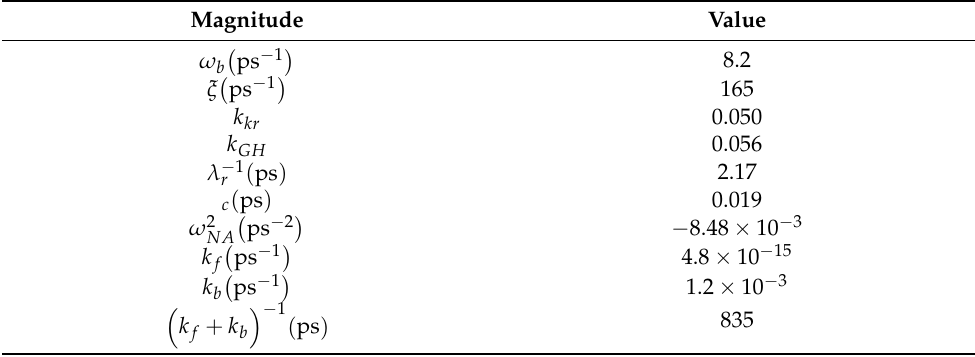
Table 10. Li + -Br − association-dissociation process parameters and reaction